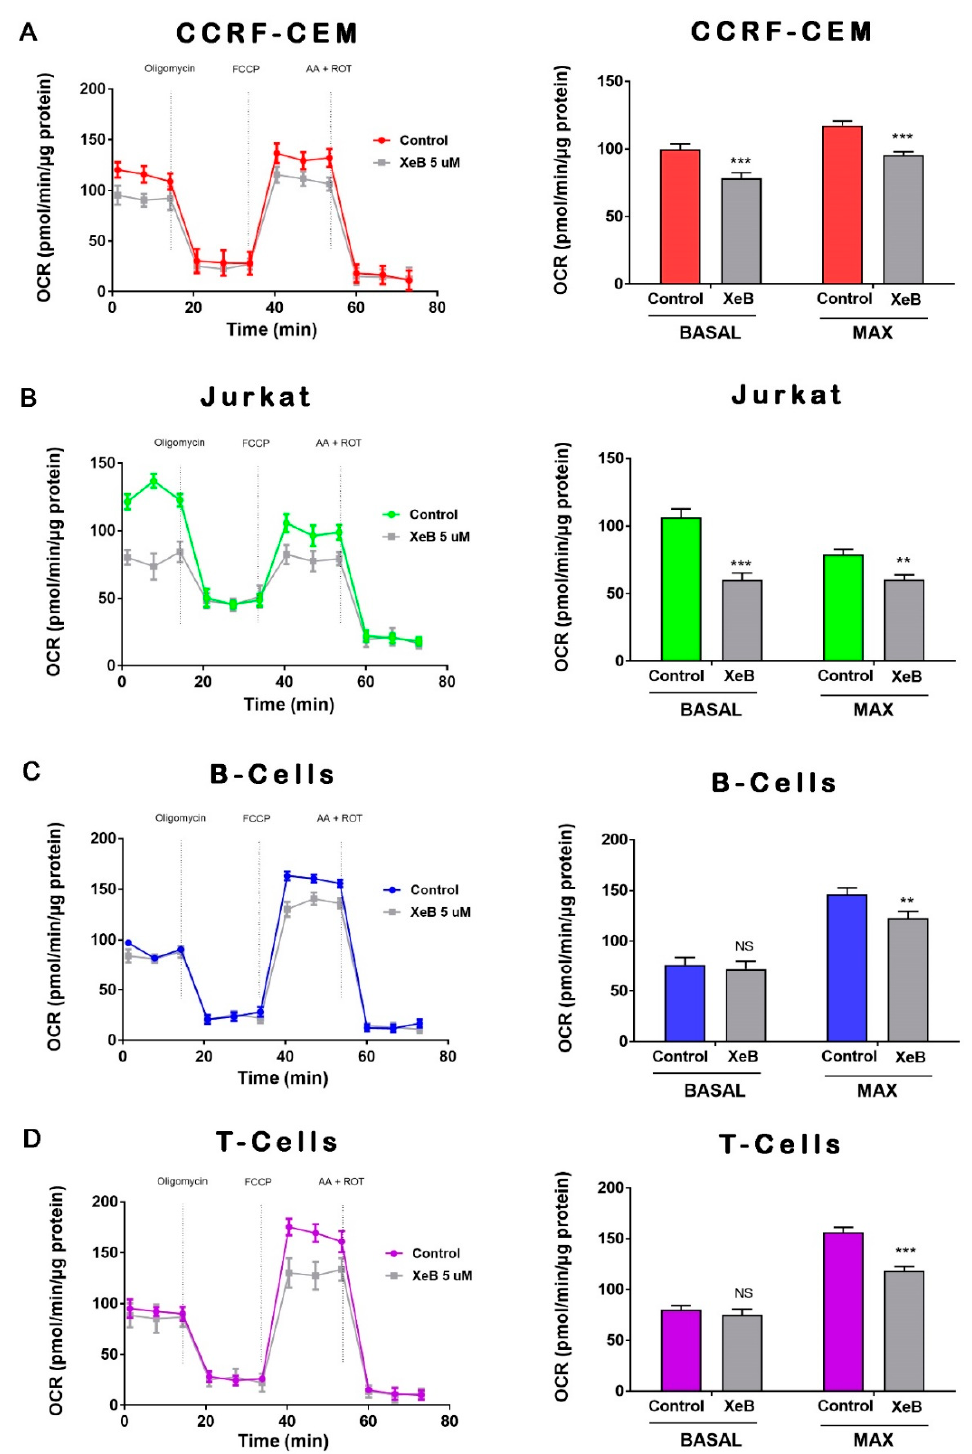
Figure 4. Effect of InsP3R inhibition on lymphocytes and T-ALL cell mitochondrial respiratory function. ( A ) Representative oxygen consumption traces (left), and basal and maximal oxygen consumption rate (OCR) analysis of CCRF-CEM control or treated with 5 µ M XeB (right). ( B ) Representative oxygen consumption traces (left) and basal and maximal oxygen consumption rate (OCR) analysis of Jurkat control cells or those treated with 5 µ M XeB (right). ( C ) Representative oxygen consumption traces (left) and basal and maximal oxygen consumption rate (OCR) analysis of control B cells or B cells treated with 5 µ M XeB (right). ( D ). Representative oxygen consumption traces (left) and basal and maximal oxygen consumption rate (OCR) analysis of T-cells control or treated with 5 µ M XeB (right). n = 3, mean ± S.E., ** p < 0.01, *** p < 0.001, NS = not significant ( t -test).